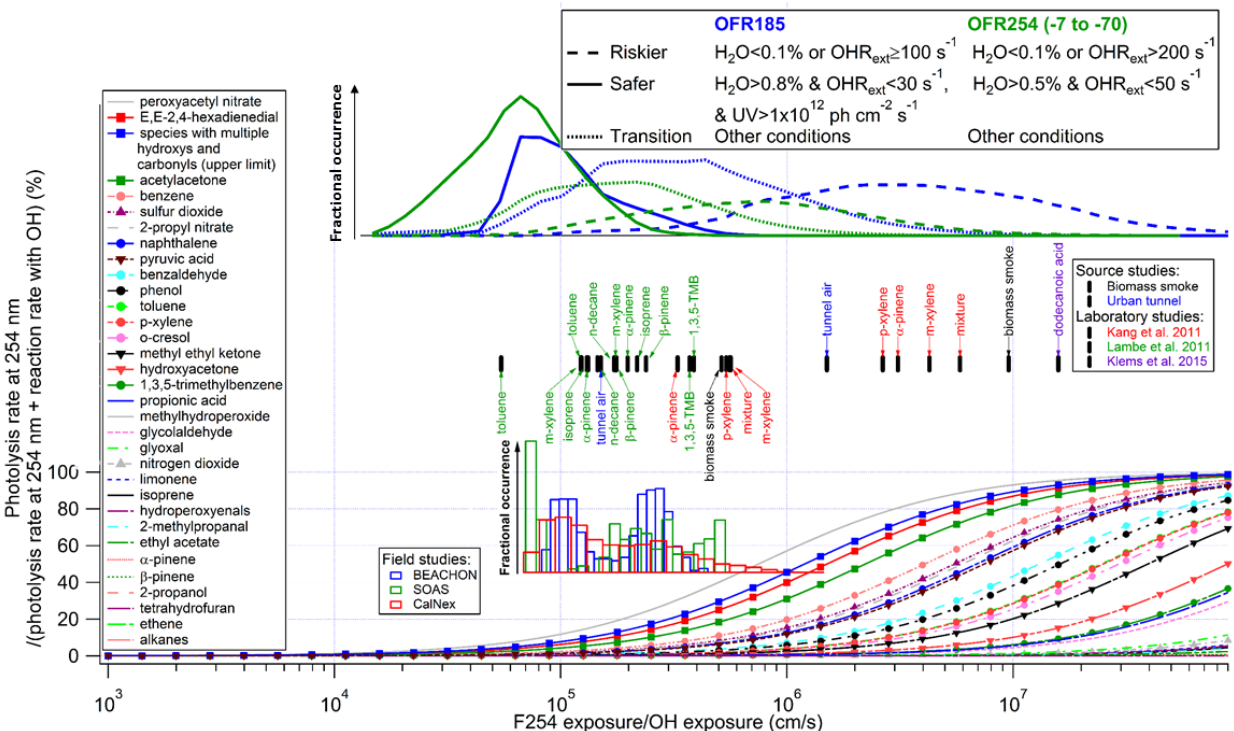
Figure 2. Same format as Fig. 1, but for the fractional importance of the photolysis rate at 254nm vs. the reaction rate with OH as a function of the ratio of exposure to 254nm (F254) and OH. The modeled frequency distributions of ratios of 254nm photon exposure to OH exposure under riskier, safer, and transition conditions for OFR185 and OFR254 (-7 to -70) are also shown. The curves of saturated carbonyl compounds and possible highly absorbing oxidation intermediates are highlighted by downward triangles and squares, respectively. The insets show histograms of model-estimated F254/OH exposures for three field studies where OFR185 was used to process ambient air. In addition to source studies of biomass smoke (FLAME-3) and urban tunnel (Tkacik et al., 2014), F254 exposure / OH exposure ratios in two laboratory studies (Kang et al., 2011; Lambe et al., 2011b) are shown in the upper inset. Colored tags indicate species used in the laboratory experiments. The lower and upper limits of F254 exposure / OH exposure ratios in the experiments with a certain source in a certain study are denoted by tags below and above the markers,